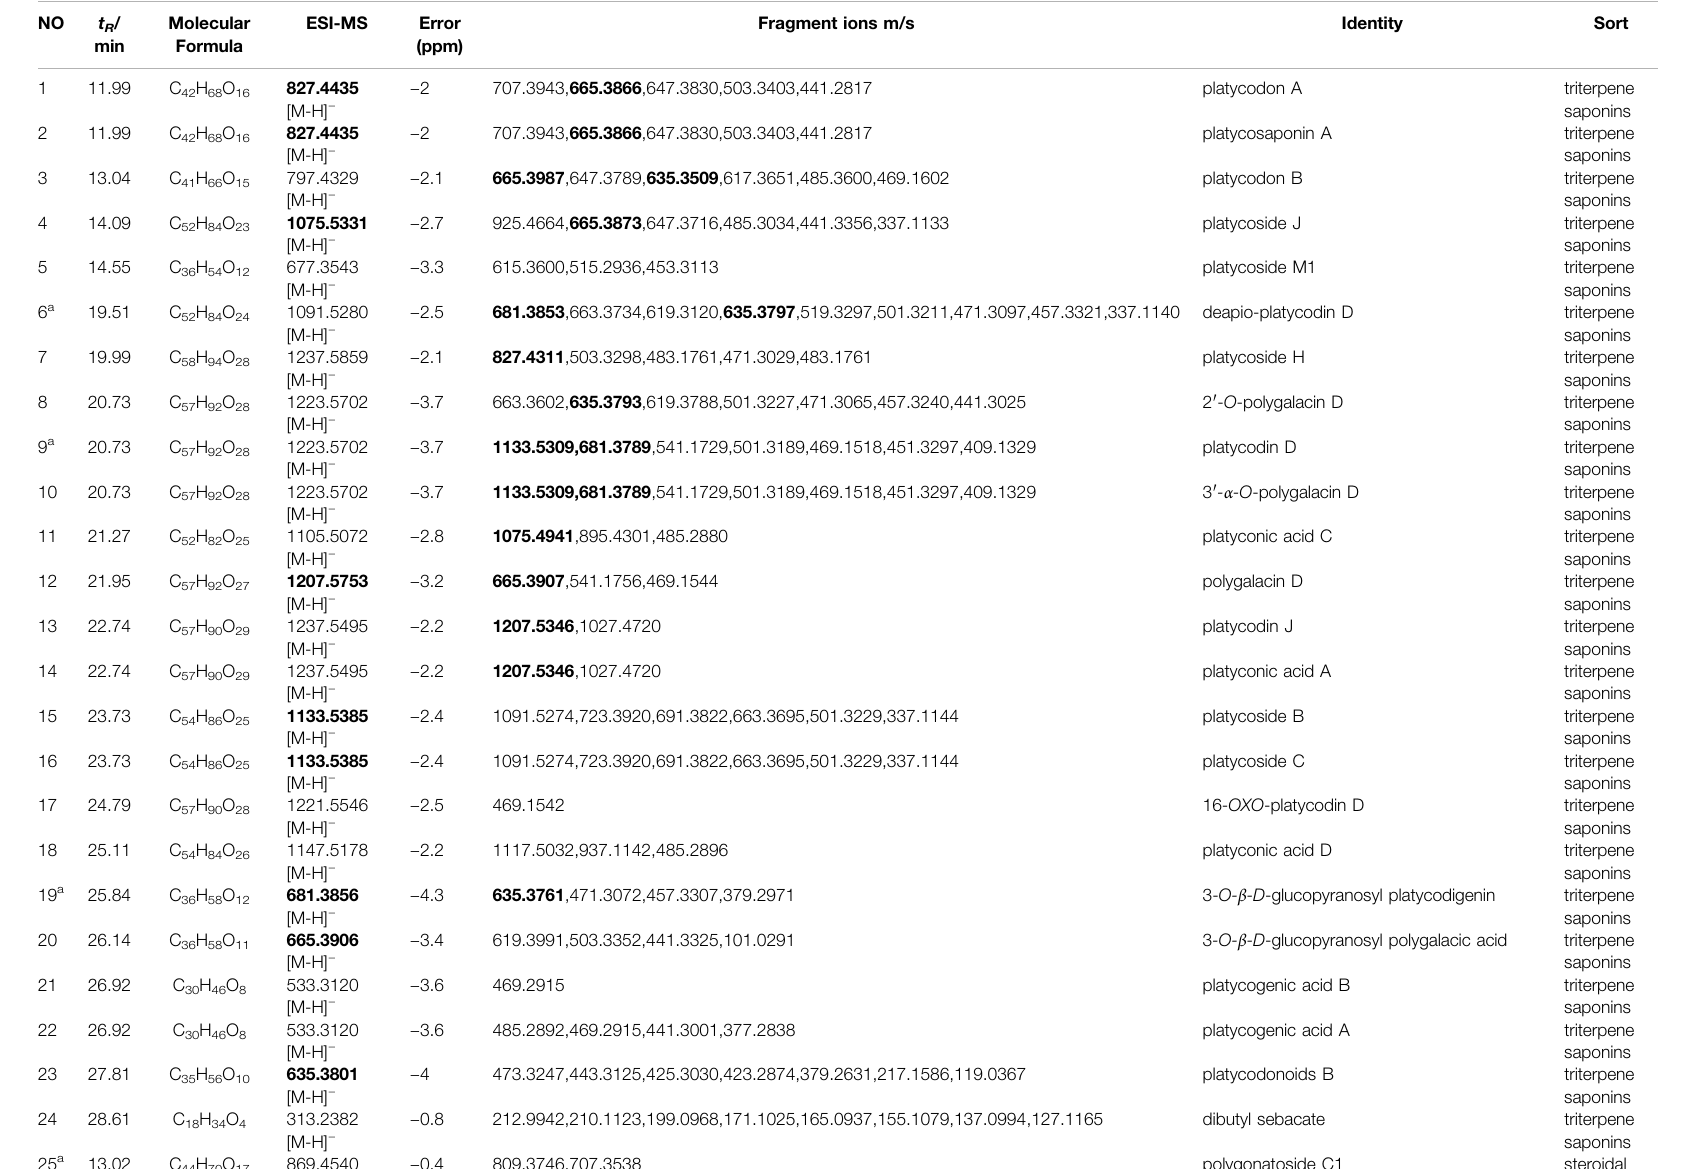
TABLE 1 | Information on chemical ingredients in Platycodon grandi fl orum